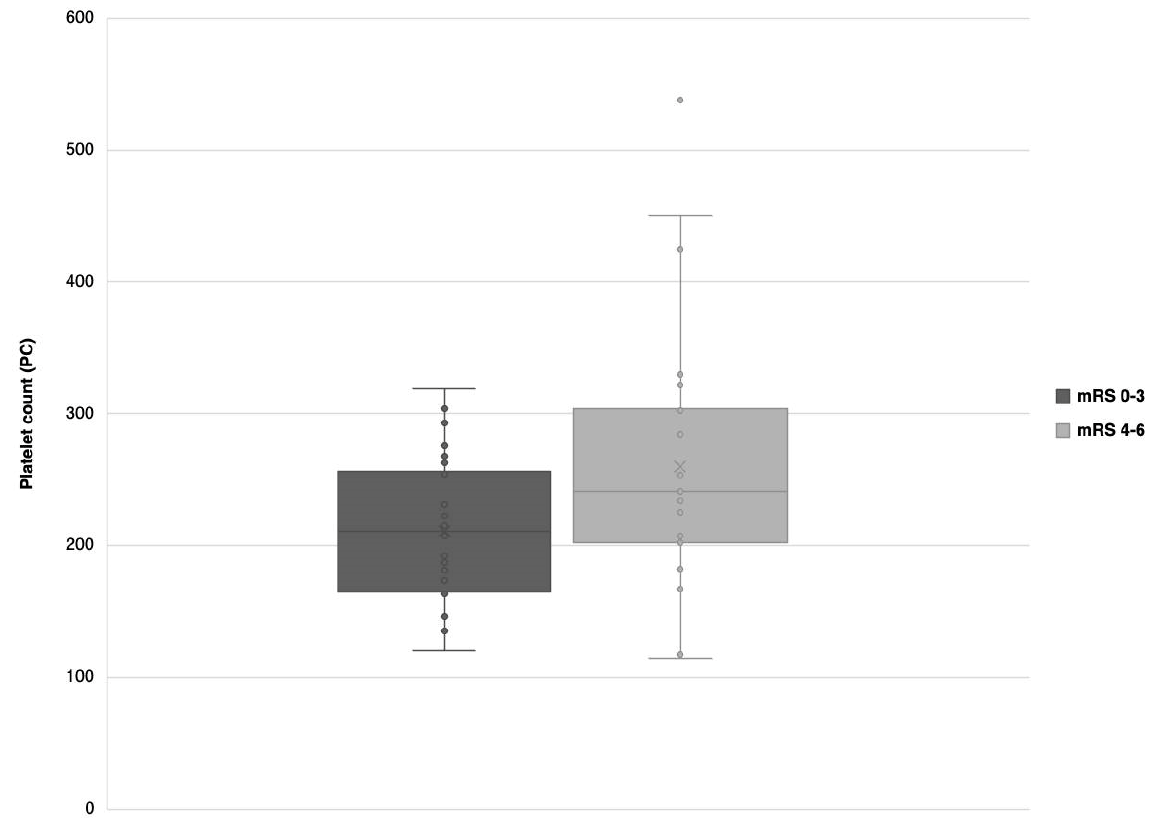
Figure 1. Box and whisker plots for PC values in patients with favorable and unfavorable outcomes. Abbreviations: modified Rankin Scale (mRS), platelet count (PC).